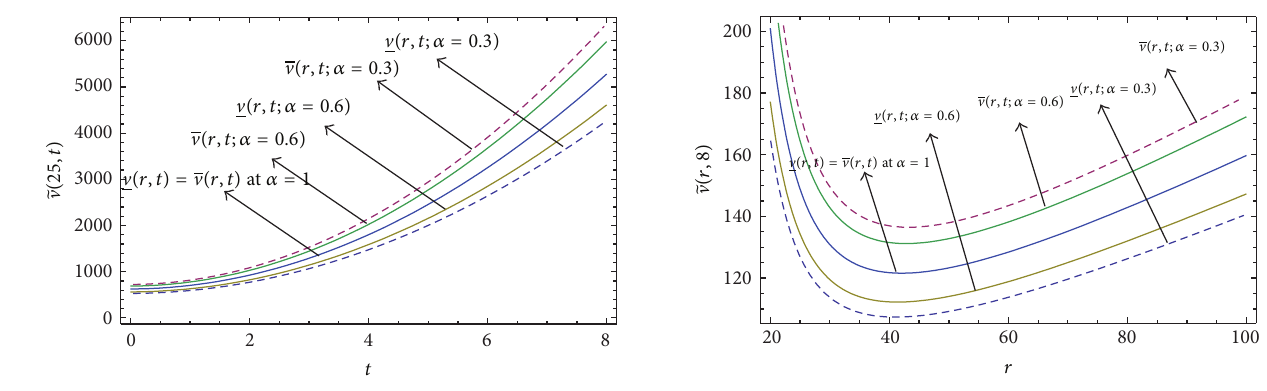
Figure 9: Interval solution of Case 4.